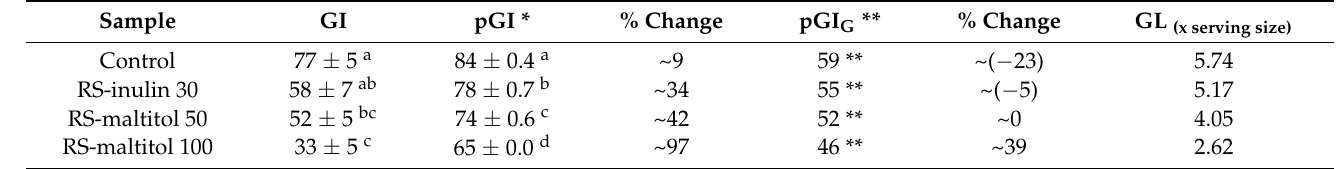
Table 4. The glycaemic index (GI) predicted glycaemic index (pGI) [33] and glycaemic load (GL) of gluten-free biscuits made with sucrose replacers and resistant